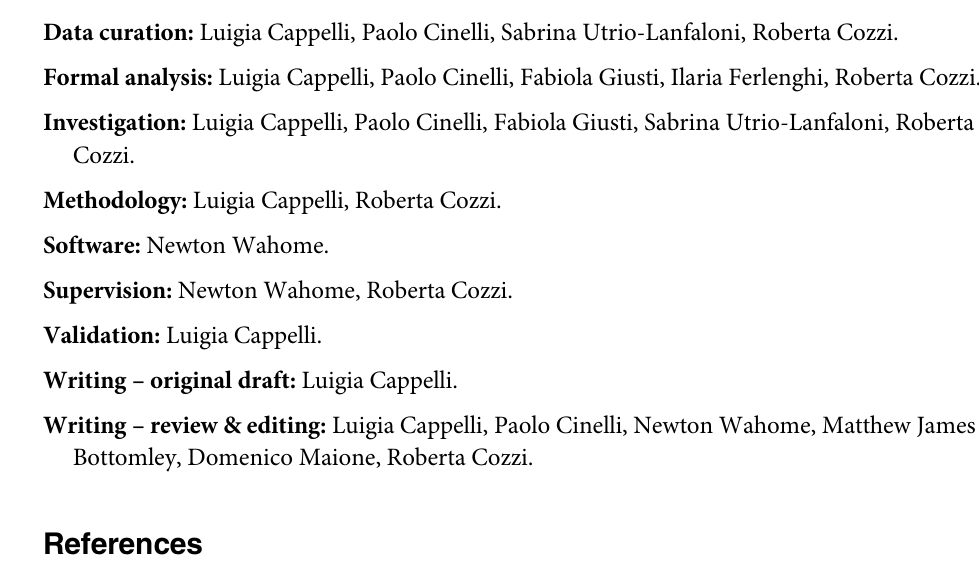
S1 Fig. Predicted 3D model of Encapsulin (A) and HBcAg (B) NPs displaying β barrel into an exposed loop. S2 Fig. TEM analysis of unstructured NPs. (A) β barrel-Qbeta (B) β barrel-encapsulin. Only aggregates or monomers were detected after affinity and size exclusion